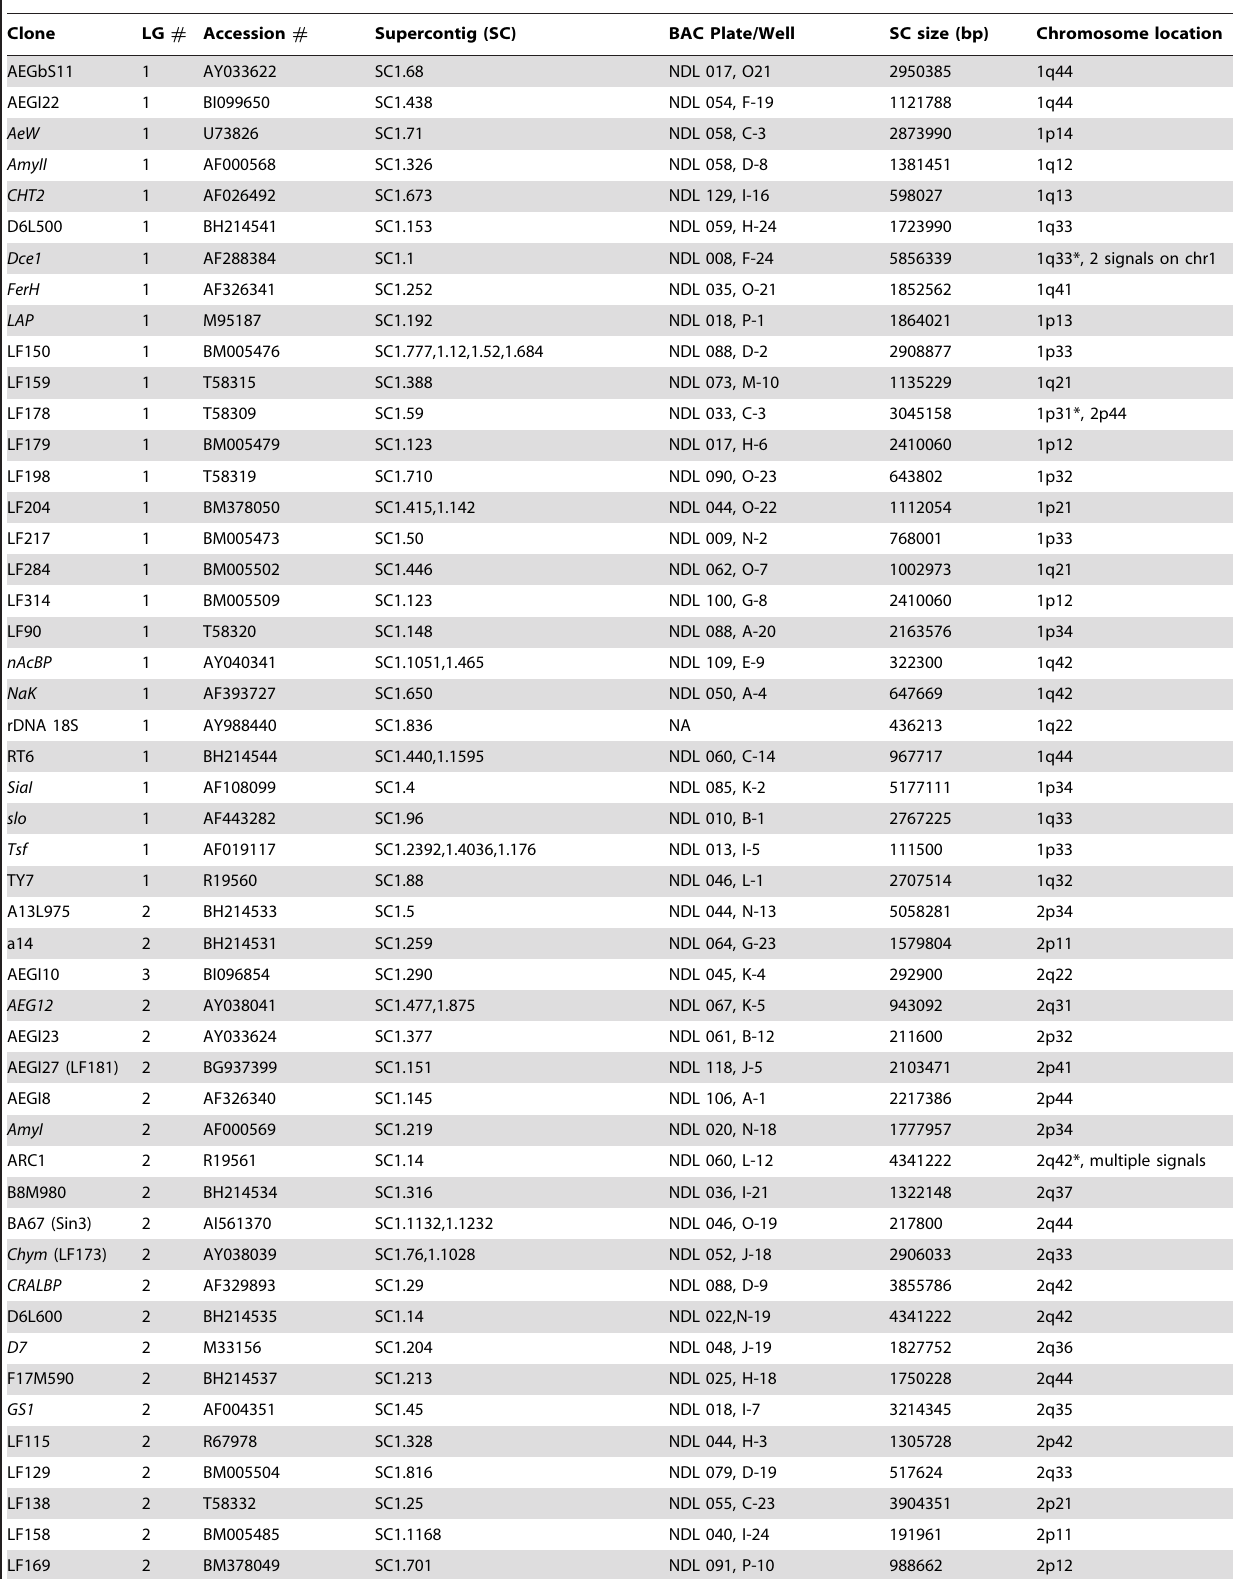
Table 1. Chromosome locations of genetic markers and genomic